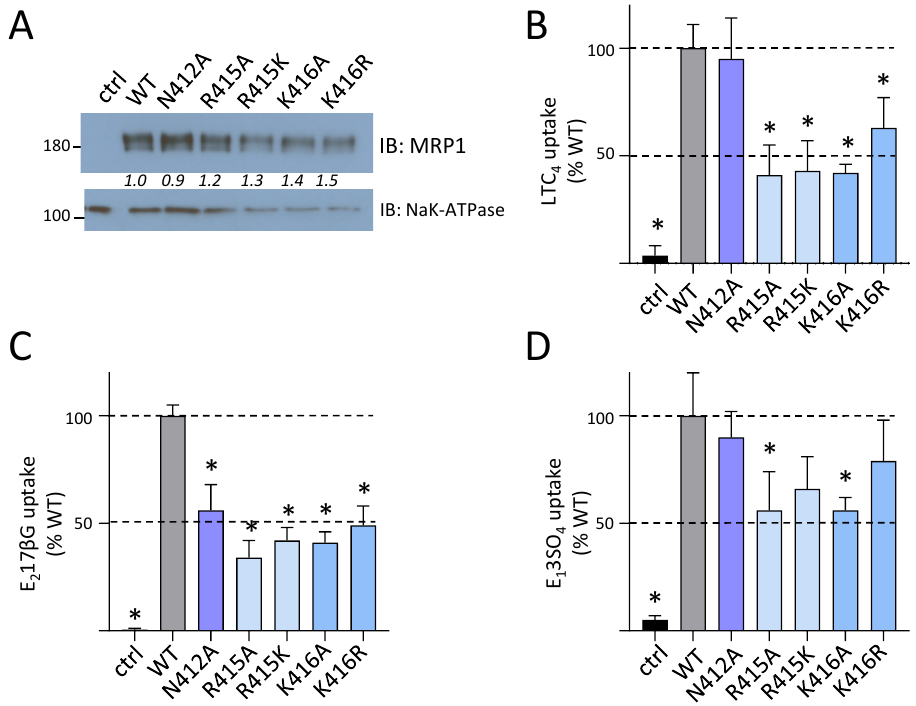
Figure 3. Effect of CL4 coupling helix mutations N412A, R415A/K and K416A/R on hMRP1 organic anion transport activity. ( A ) Shown is a representative immunoblot (2 s exposure) of inside-out membrane vesicles (1 µ g protein per lane) prepared from HEK cells transfected with wild-type (WT) and N412A, R415A/K and K416A/R mutant hMRP1 pcDNA3.1 expression vectors as well as untransfected HEK cells (ctrl). Blots were probed with anti-hMRP1 (Mab QCRL-1) and anti-Na + /K + - ATPase as a membrane protein loading control; the region between hMRP1 and Na + /K + -ATPase signals has been cropped out. Molecular weight markers (kDa) are to the left. Italicized numbers between the 2 panels indicate mutant hMRP1 levels relative to wild-type hMRP1 after correcting for levels of the protein loading control as measured by densitometry. ( B – D ) Transport activity was measured as ATP-dependent uptake of ( B ) [ 3 H]LTC 4 , ( C ) [ 3 H]E 2 17 β G and ( D ) [ 3 H]E 1 3SO 4 (in the presence of 3 mM S-methyl GSH) into inside-out membrane vesicles prepared from transfected cells and expressed as a percent of uptake by wild-type hMRP1. The values shown have been adjusted to take into account minor differences in mutant hMRP1 levels in the membrane vesicles relative to wild-type (WT) hMRP1. Bars represent the mean values ( ± SD) of results obtained from three independent experiments. * Significantly different from wild-type hMRP1 ( p <